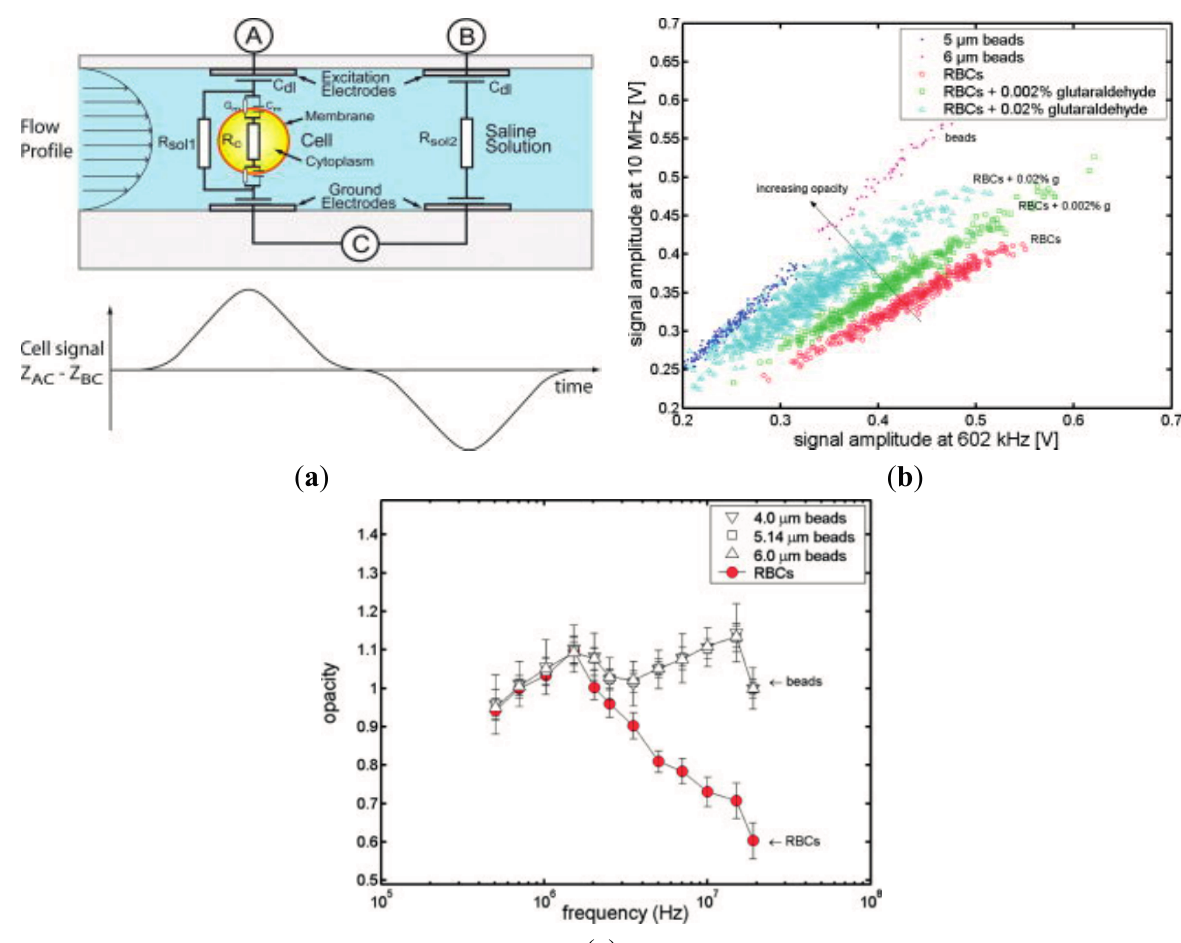
Figure 2. ( a ) The second-generation microfluidic impedance flow cytometry where the parallel overlap micro electrodes were used to replace the previously reported coplanar micro electrodes; ( b ) Two-frequency impedance data of polystyrene beads, normal red blood cells and fixed red blood cells, which can be classified to an extent based on opacity defined as |Z high |/|Z ref |; ( c ) Opacity spectrum of red blood cells and polystyrene beads where no significant difference was noticed among the opacity spectra for polystyrene beads of different diameters, confirming that opacity can be used to normalize the particle size. In addition, a decrease in opacity at the high frequency domain of red blood cells compared to polystyrene beads was observed, confirming that the cytoplasm of red blood cells is more conductive than polystyrene beads